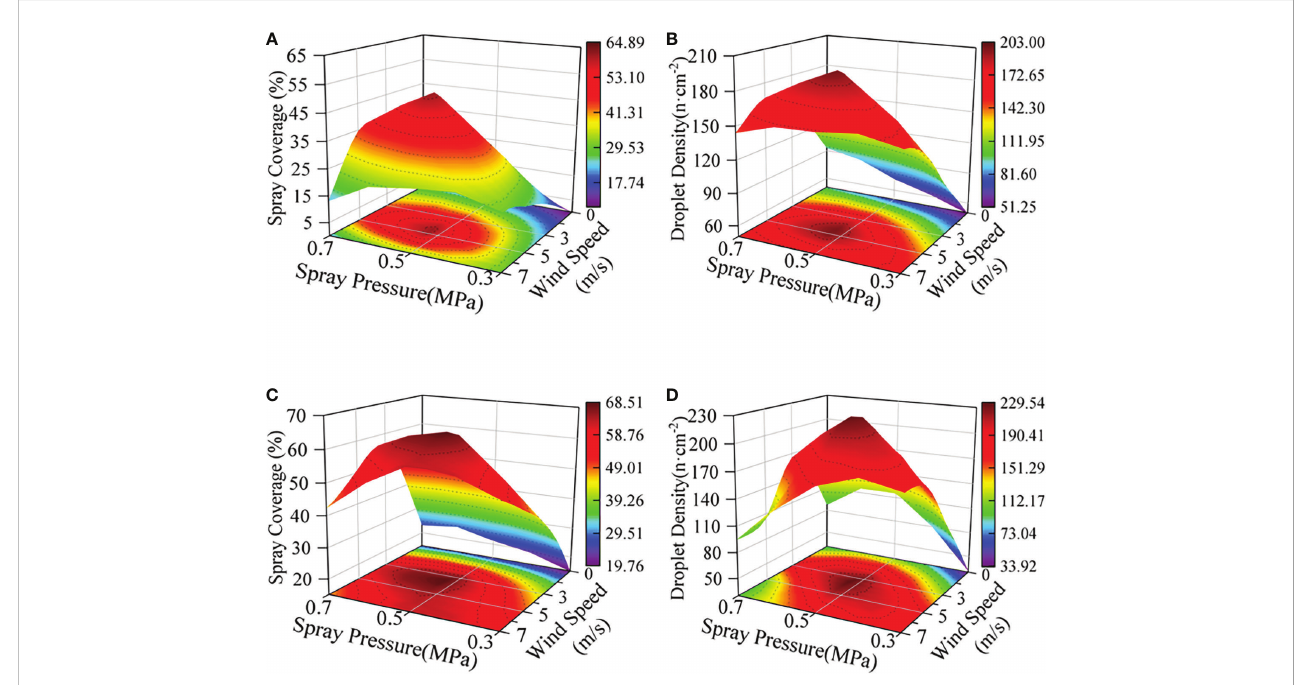
FIGURE 6 Response of Spray Deposition Distribution to Spray Pressure and Wind Speed (AA2-3W). (A, B) : adaxial side, (C, D) : abaxial side, (A, C) : spray coverage, (B, D) : droplet